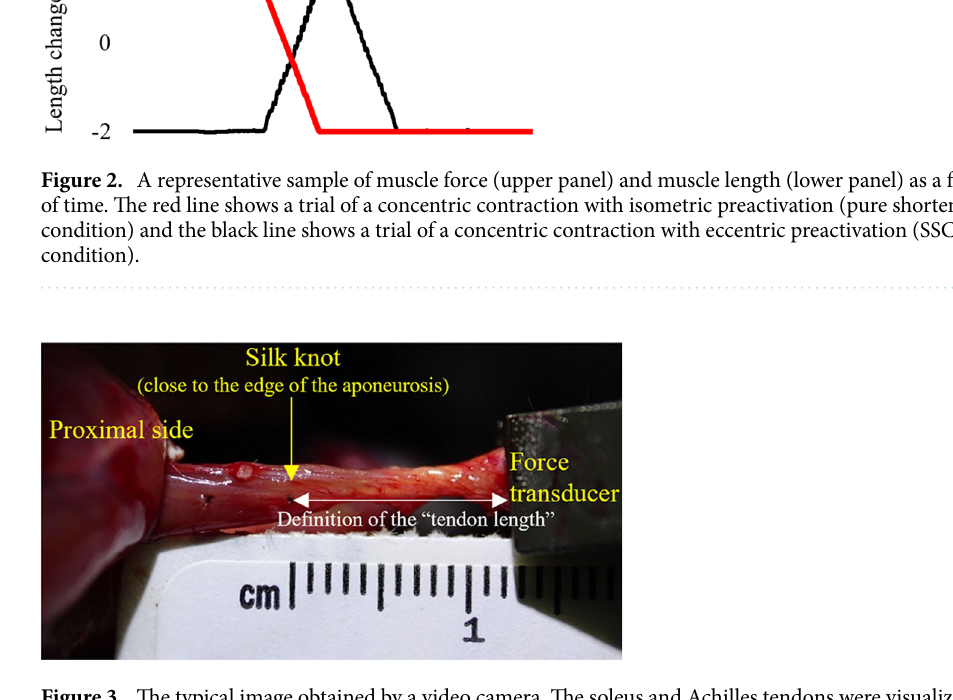
Figure 3. The typical image obtained by a video camera. The soleus and Achilles tendons were visualized using a video camera. The position of the silk knot and the edge of the black grip (force transducer) were recorded to measure the Achilles tendon length during the SSC and pure shortening